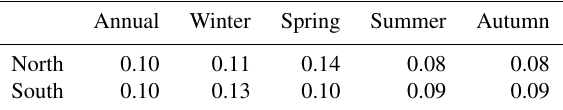
Table 9. Linear surface air temperature trends (in Kelvin per decade) for the period 1878–2020 over the northern ( > 60 ◦ N) and southern ( < 60 ◦ N) Baltic Sea drainage basin (1878–2020 is se- lected for comparison with Rutgersson et al., 2014, with an equally long time period). Trends are significant at p < 0 . 05. Data are from the updated CRUTEM4v dataset (Jones et al., 2012). Data source: CRUTEM4v dataset (Jones et al.,